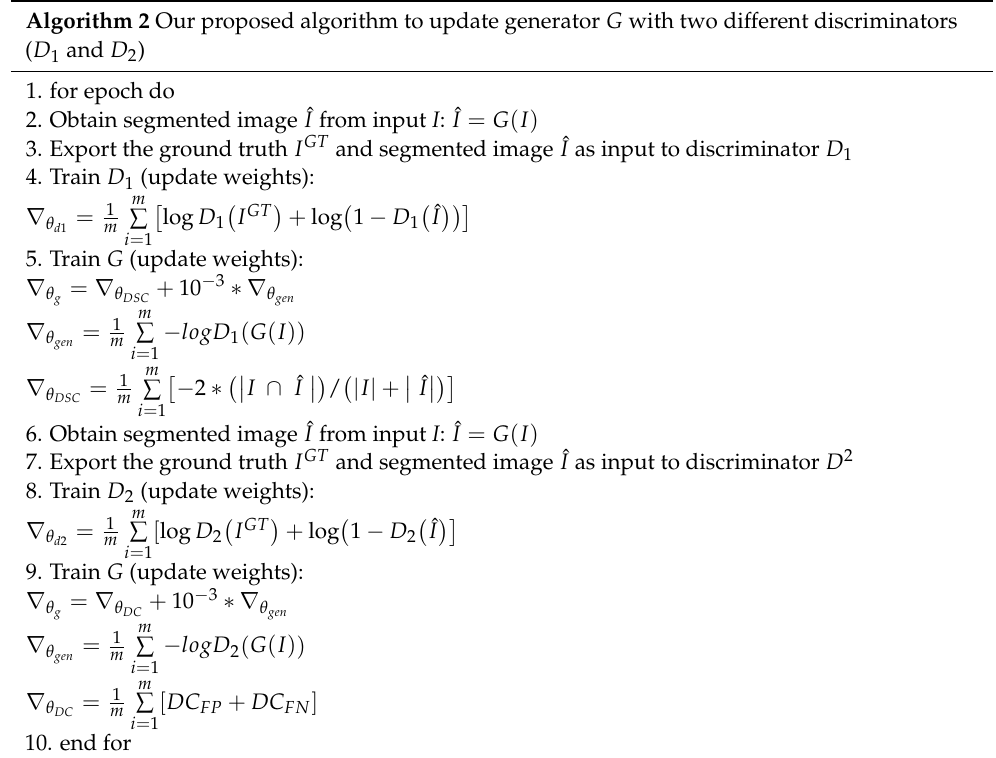
Algorithm 2 Our proposed algorithm to update generator 𝐺 with two different